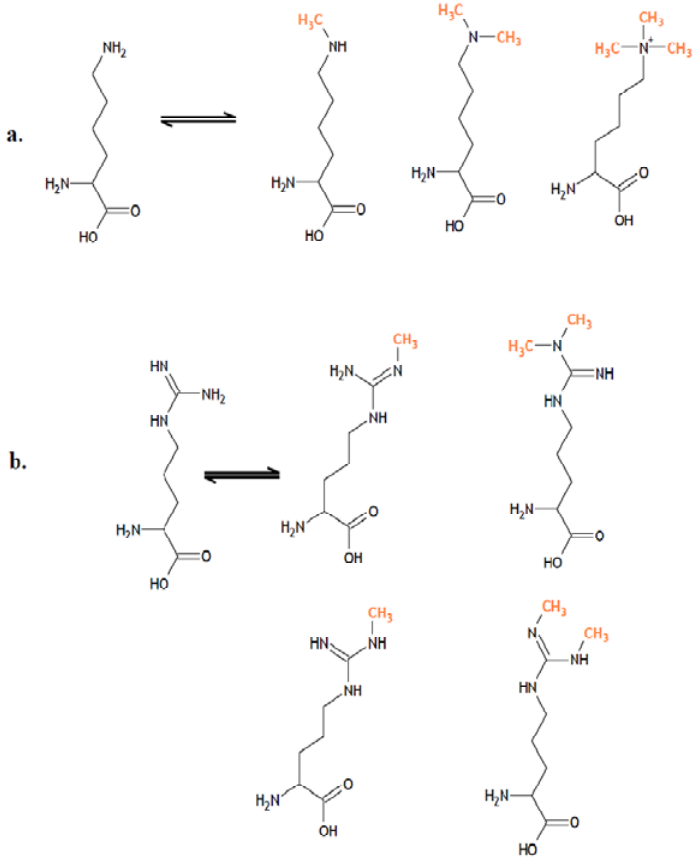
Figure 2. Methylation patterns of proteins at the lysine and arginine residues. In the histones, it is possible to find ( a ) mono-, di- and trimethylated forms of lysine, as well as ( b ) monomethylated and dimethylated forms for